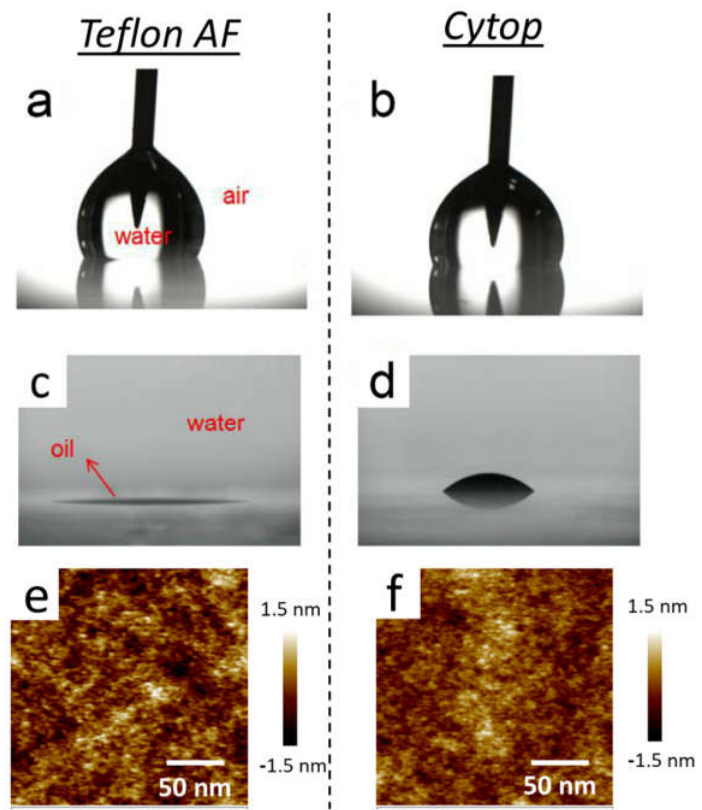
Figure 3. Water/air contact angle on the coating of ( a ) Teflon AF and ( b ) Cytop. Oil/water contact angle on the coating of ( c ) Teflon AF and ( d ) Cytop. AFM image of ( e ) Teflon AF surface and ( f ) Cytop surface.